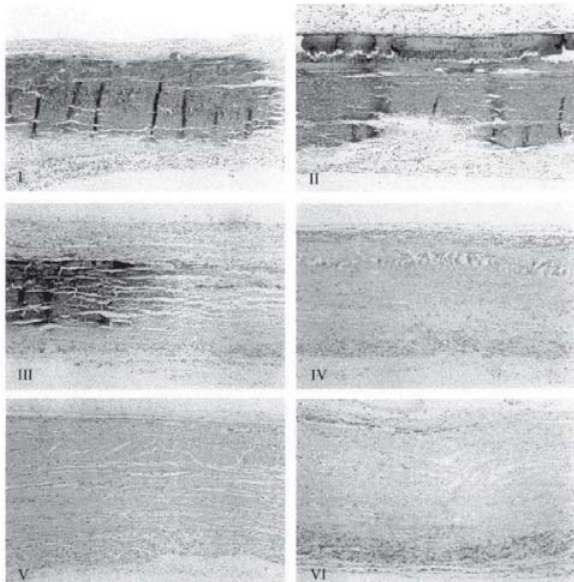
Fig. 2 – Fotomicrografia mostrando os graus de calcificação do pericárdio bovino de acordo com os tratamentos empregados